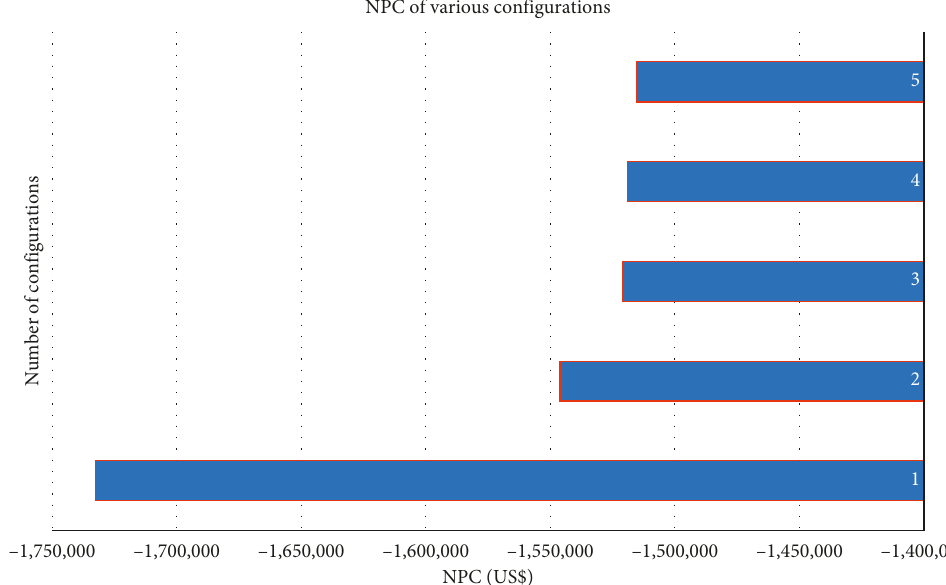
Figure 22: NPC for various configurations of the hybrid power plant systems. Table 7: The optimal power plant systems.